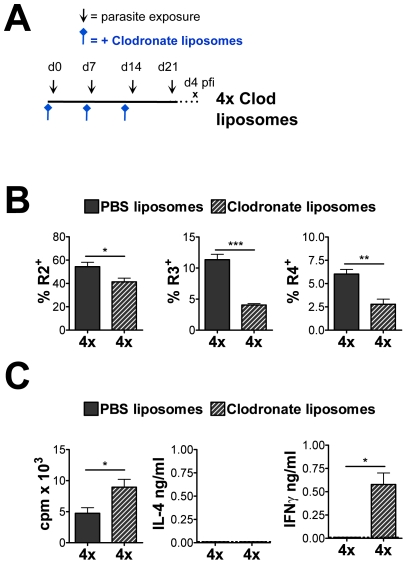
Removal of phagocytic cells through clodronate liposome treatment partially
restores lymphocyte responsiveness.(A) PBS- or clodronate-liposomes were given to 4x mice intradermally as
indicated prior to infection. (B) Percentage of cells defined by flow cytometry
as R2 eosinophils, R3 (MHC-IIlo AAMlike) and R4
(MHC-IIhi DC) recovered from 4x mice that received PBS- or
clodronate liposomes. Values are the mean percentage of cells + SEM
(n = 4–5 mice). (C) Antigen-specific in
vitro proliferation and cytokine production by sdLN cells from 1x
mice and 4x mice treated with PBS- or clodronate-liposomes. Results show the
mean c.p.m. or pg cytokine/ml + SEM (n = 4–5
mice). Significance shown between groups indicated by connector bars, one
experiment of two is shown giving similar results.